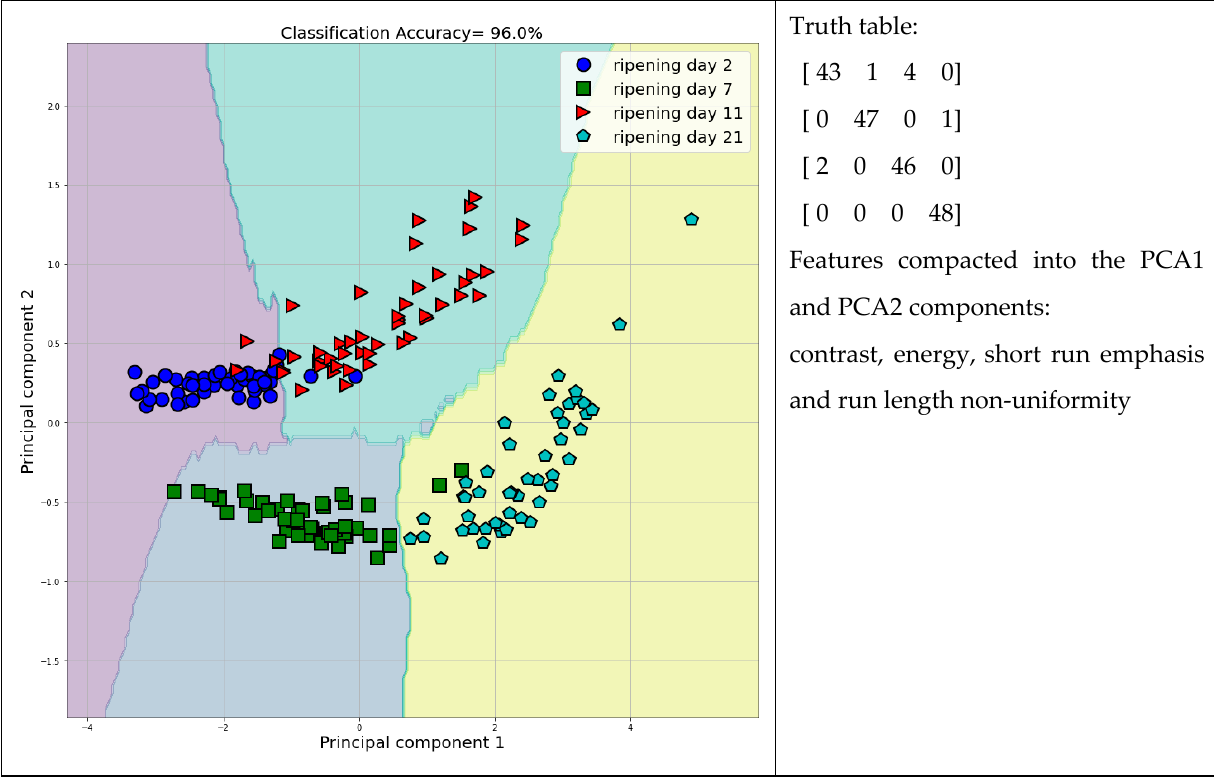
Figure 3. Scatter diagram of the discrimination, including textural features, amongst banana peel samples from days 2, 7, 11, and 21.